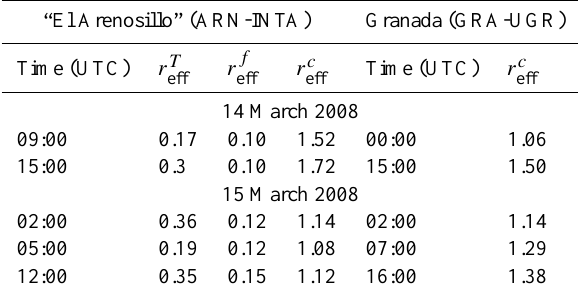
Table 6. Effective radius ( r GL ) (in µm) for the total ( T ), fine ( f ) eff and coarse ( c ) modes in ARN site and for the coarse mode ( c ) in GRA site, as calculated from ground-level in-situ particle size dis- tribution